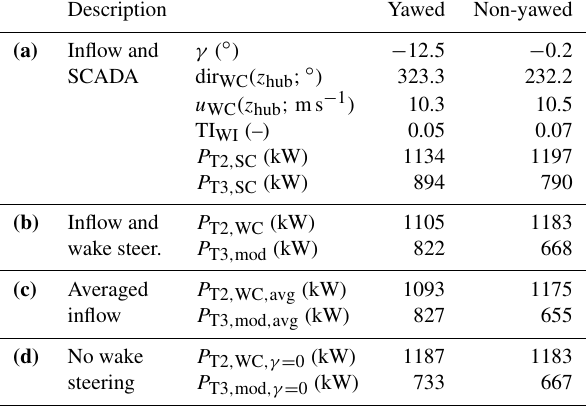
Table 2. Inflow and power output for the yawed case (left column) and non-yawed case (right column) shown in Fig. 12d and e. The upper part (a) presents the inflow measurement from the Doppler lidars and power from the SCADA data. The lower three parts show the power estimated from the inflow-profiling lidar for T2 and the prediction of the Qian and Ishihara (2018) model for T3 based on the inflow values (b) , the averaged inflow values only varying γ (c) and the inflow values with γ = 0 (d)